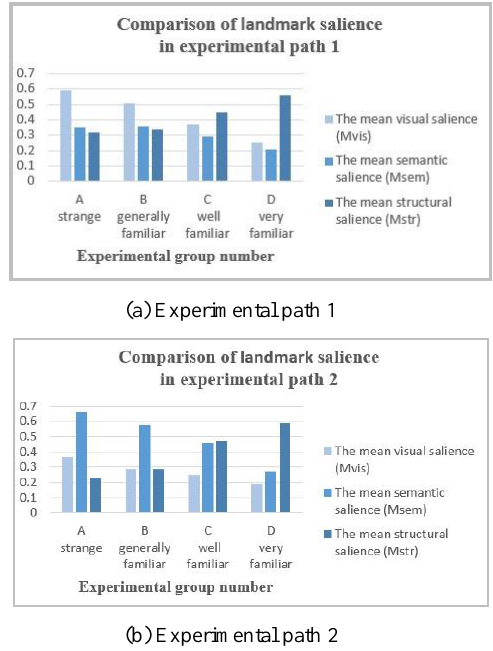
Figure 6. Comparison of landmark salience in hand-painted